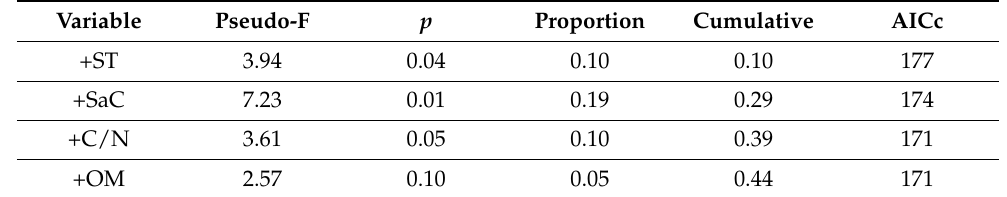
Table 5. Results of sequential tests of DISTLM (distance-based linear modelling) on soil samples that were collected under five soil conditions in the experimental site (Li é tor, Castilla La Mancha, Spain).